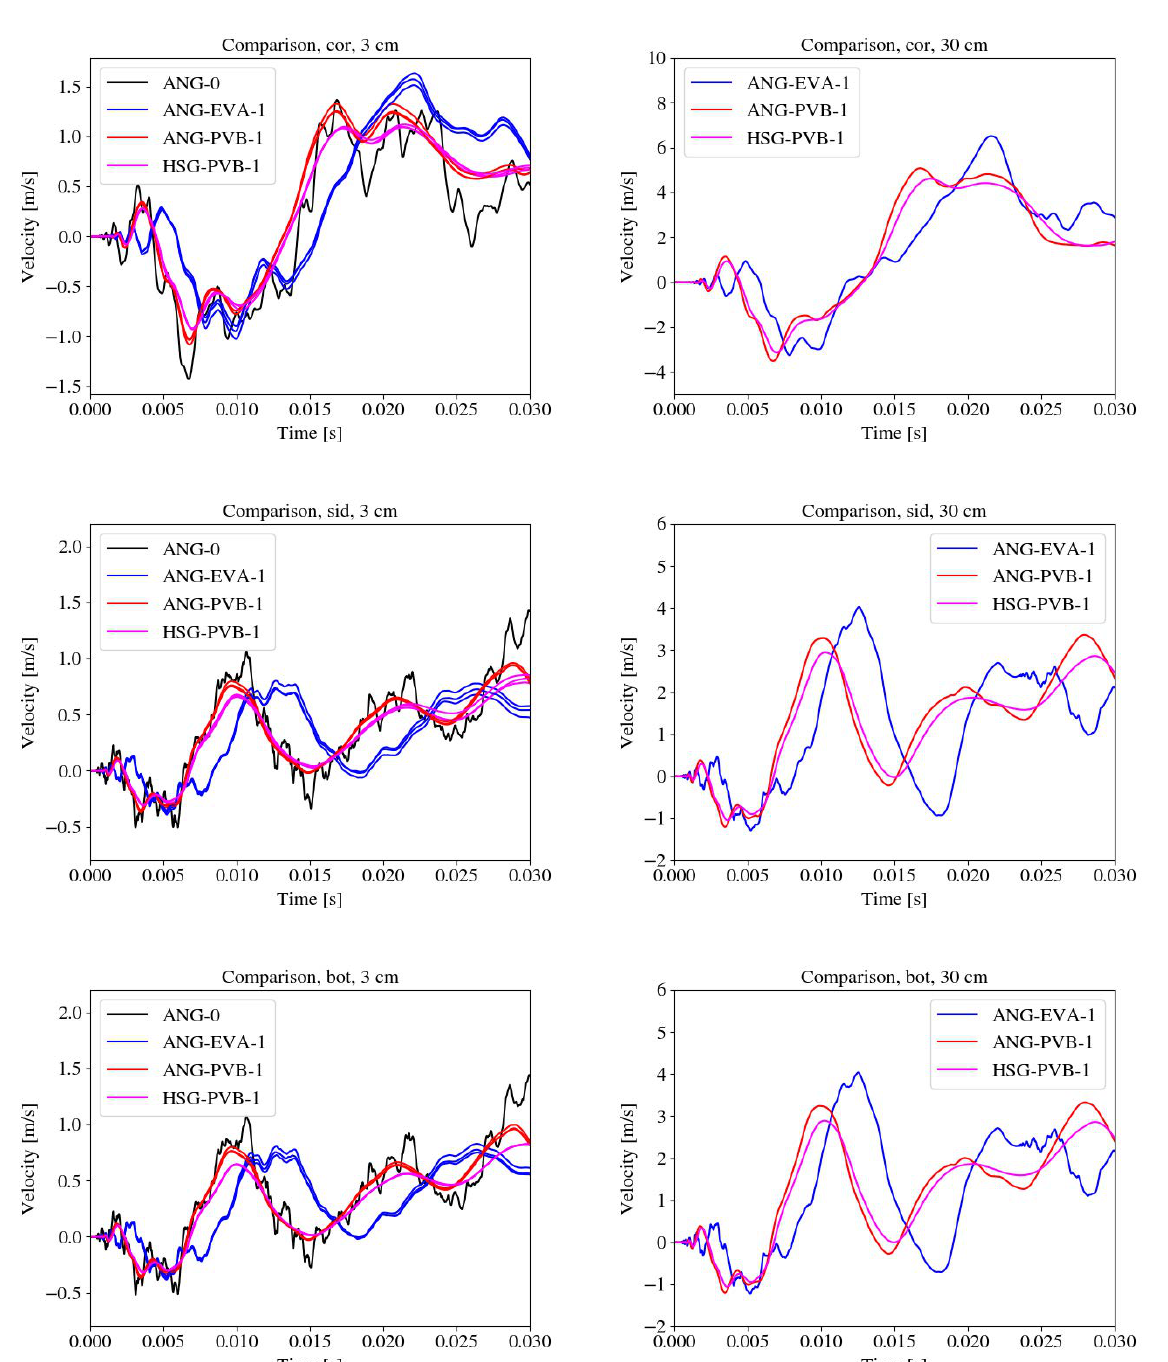
Fig. 5 Velocities at the corner (cor), at the midpoint of the side edge (sid), and at the midpoint of the bottom edge (bot) for monolithic (ANG- 0) and laminated (ANG-EVA, ANG-PVB, and HSG-PVB) glass samples for the impact height 3 cm or 30